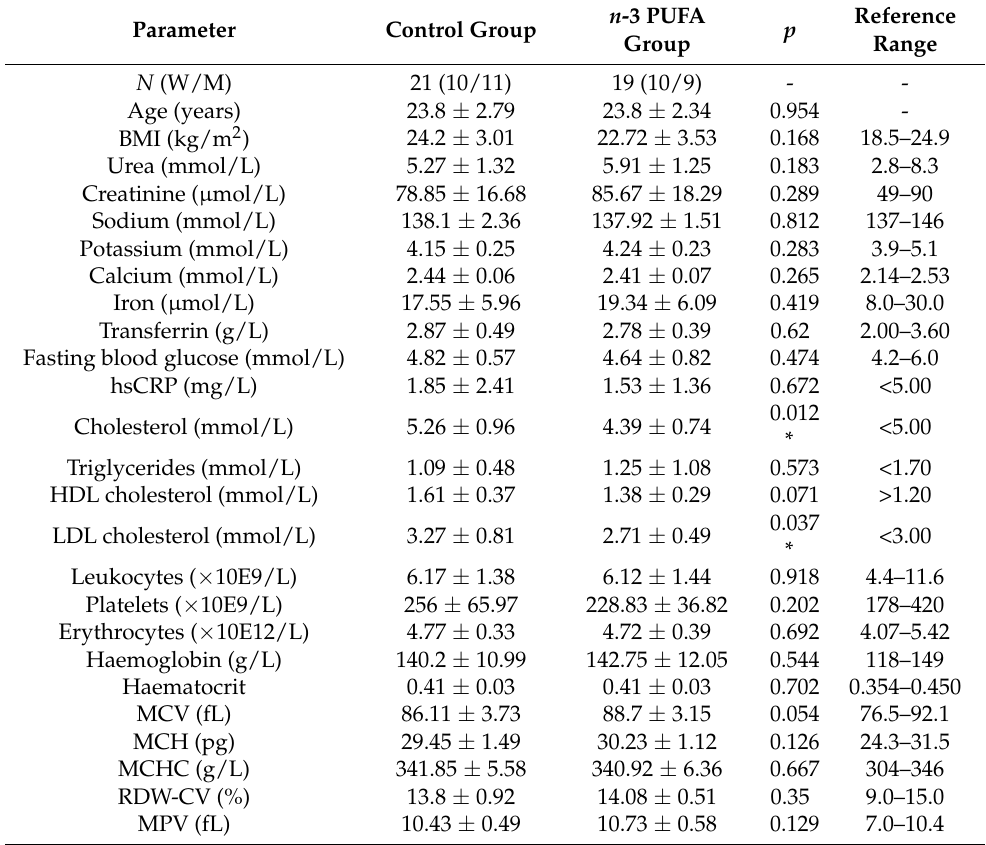
Table 1. General and biochemical characteristics of study